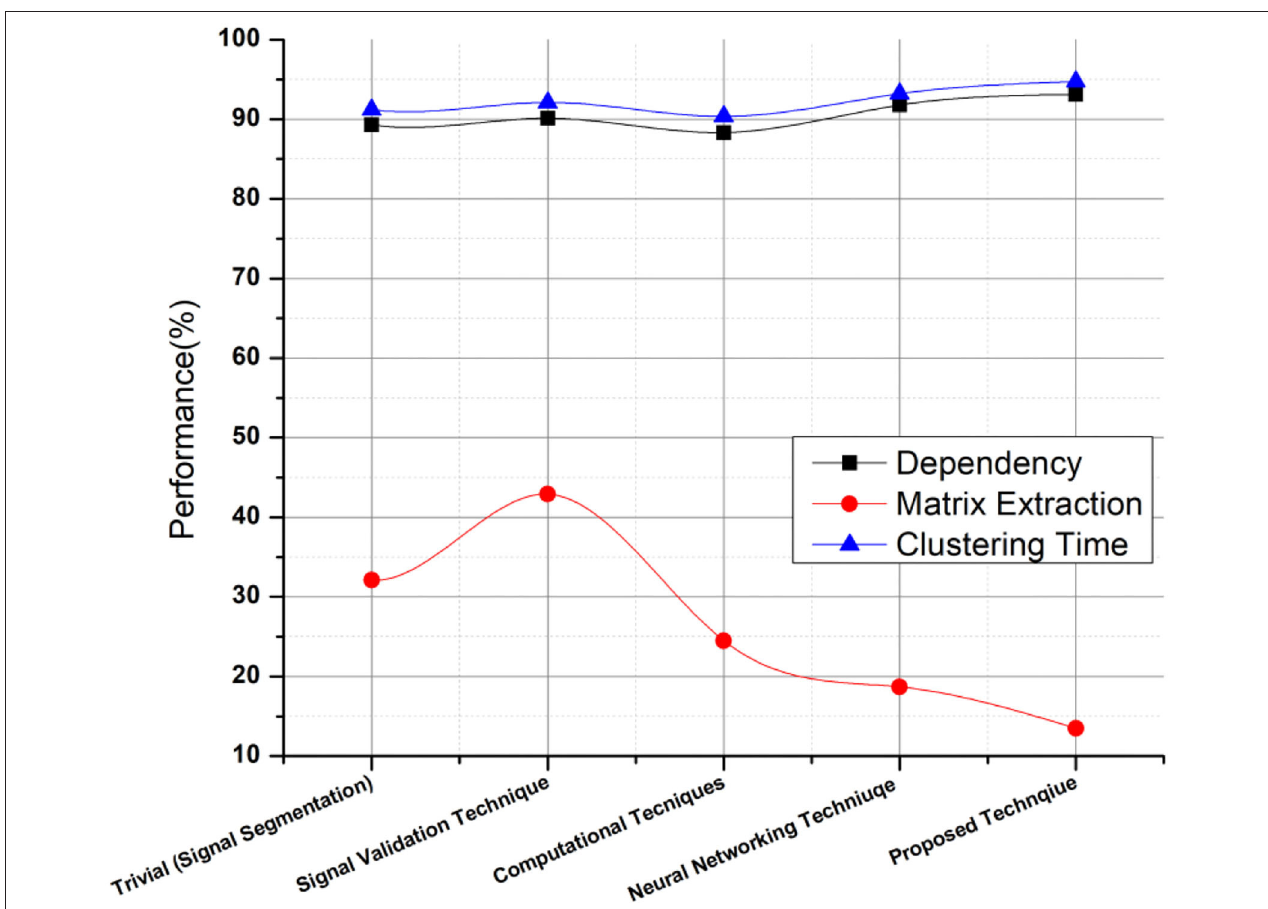
FIGURE 5 | Performance computation of proposed technique on independent